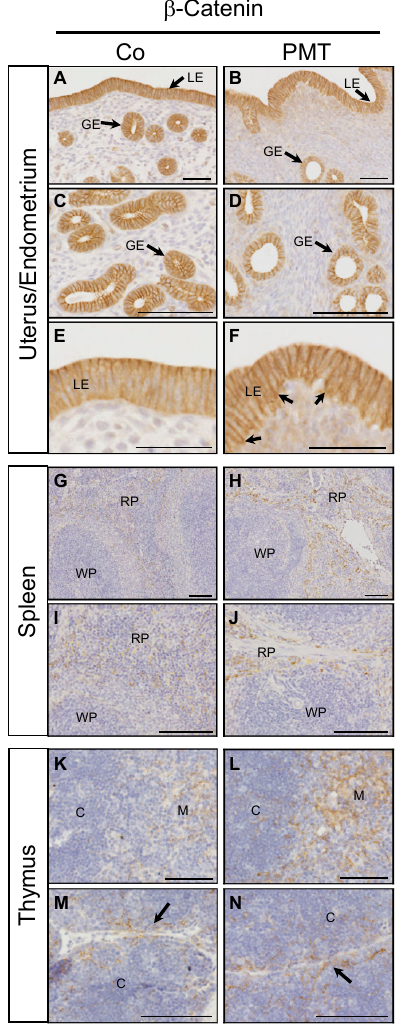
Figure 5. PMT stimulates active β -catenin in vivo. Immunohistochemical analysis of active β -catenin in uterine ( A – F ), spleen ( G – J ) and thymus ( K – N ) tissues of animals treated with either PMT (3 ng) or vehicle control (Co) for one month. Micrographs represent 5 µ m para ffi n sections stained with specific antibodies recognizing active β -catenin as described in the Methods. Uterus / endometrium: luminal epithelium (LE), glandular epithelium (GE); spleen: red pulp (RP), white pulp (WP); thymus: cortex (C), medulla (M). Arrows in F indicate increased basal epithelial membrane staining of β -catenin in LE cells. Arrows in ( M , N ) indicate the connective tissue septae that demarcate the thymic lobules. Scale bars: (A–D)(G–N): 100 µ m; (E,F): 50 µ